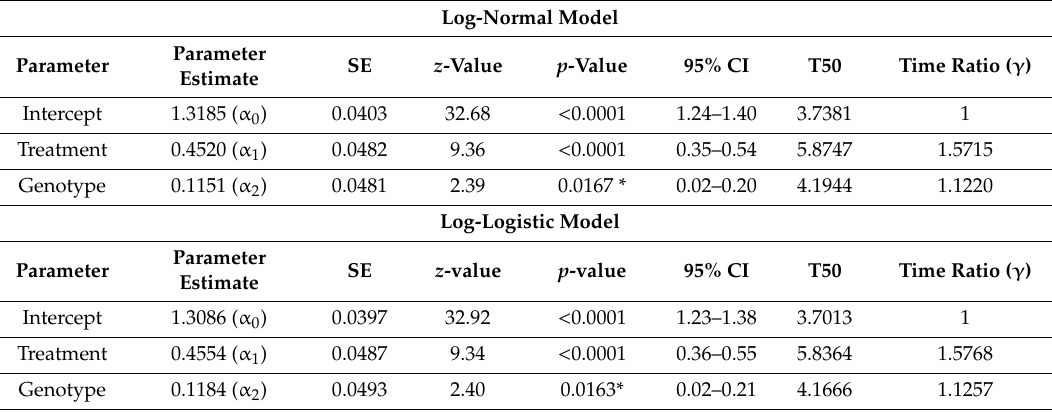
Table 4. Summary table of the AFT model (log-normal and log-logistic distribution). z -values test the hypothesis that the parameter value is zero. p -values test the significance of the corresponding parameter. The asterisks on p -values indicate a statistical significance ( α <